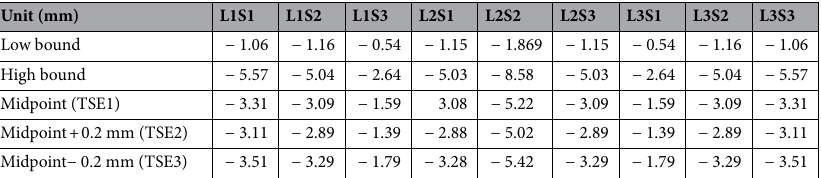
Table 8. The target deflection values for symmetric single void 20 voxel beam reestimated using the true material properties for experimental validation purposes.